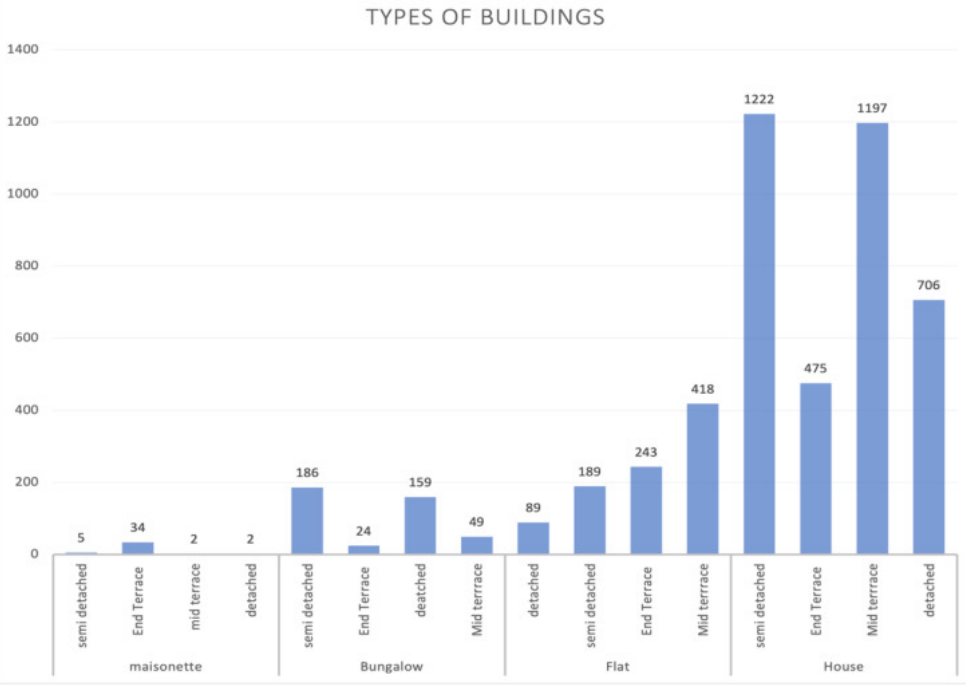
Figure 6. Different types of buildings from the building data utilized. Building